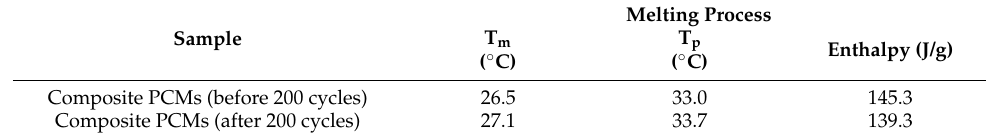
Figure 8. DSC curves of the composite PCM before and after 200 cycles. Table 3. Thermal characteristics of composite PCMs before and after cycling. Table 4. Comparison of thermal properties of composite PCMs.